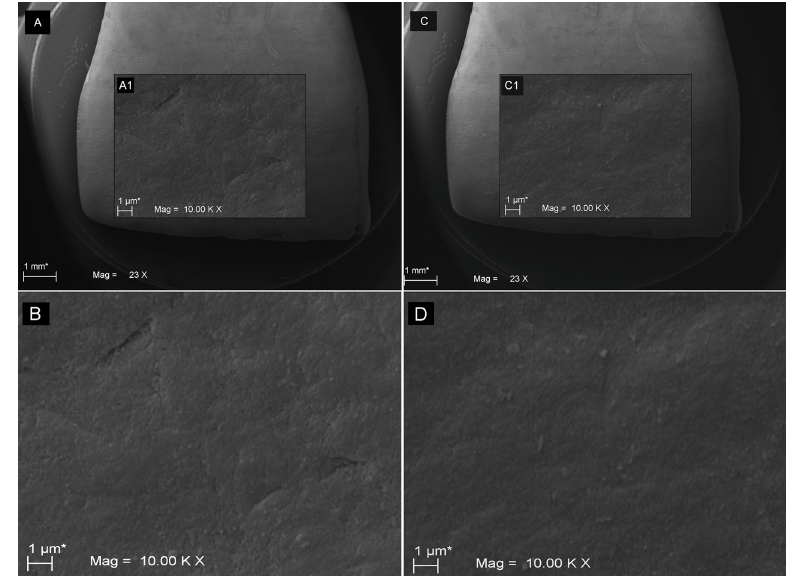
Figure 1. SEM images showing the human enamel surface alterations before and after the glycine powder use (group A). The images show a lot of enamel irregularities: ( A ) 23 × magnification image of non-treated half part of tooth; ( B , magnification of A1 in A ) higher magnification (10,000 × ) of non-treated enamel. Meanwhile, the ( C ) 23 × and ( D , magnification of C1 in C ) 10,000 × demonstrate the enamel surface after treatment showing a reduction of enamel irregularities. Coatings 2019 , 9 , x FOR PEER REVIEW